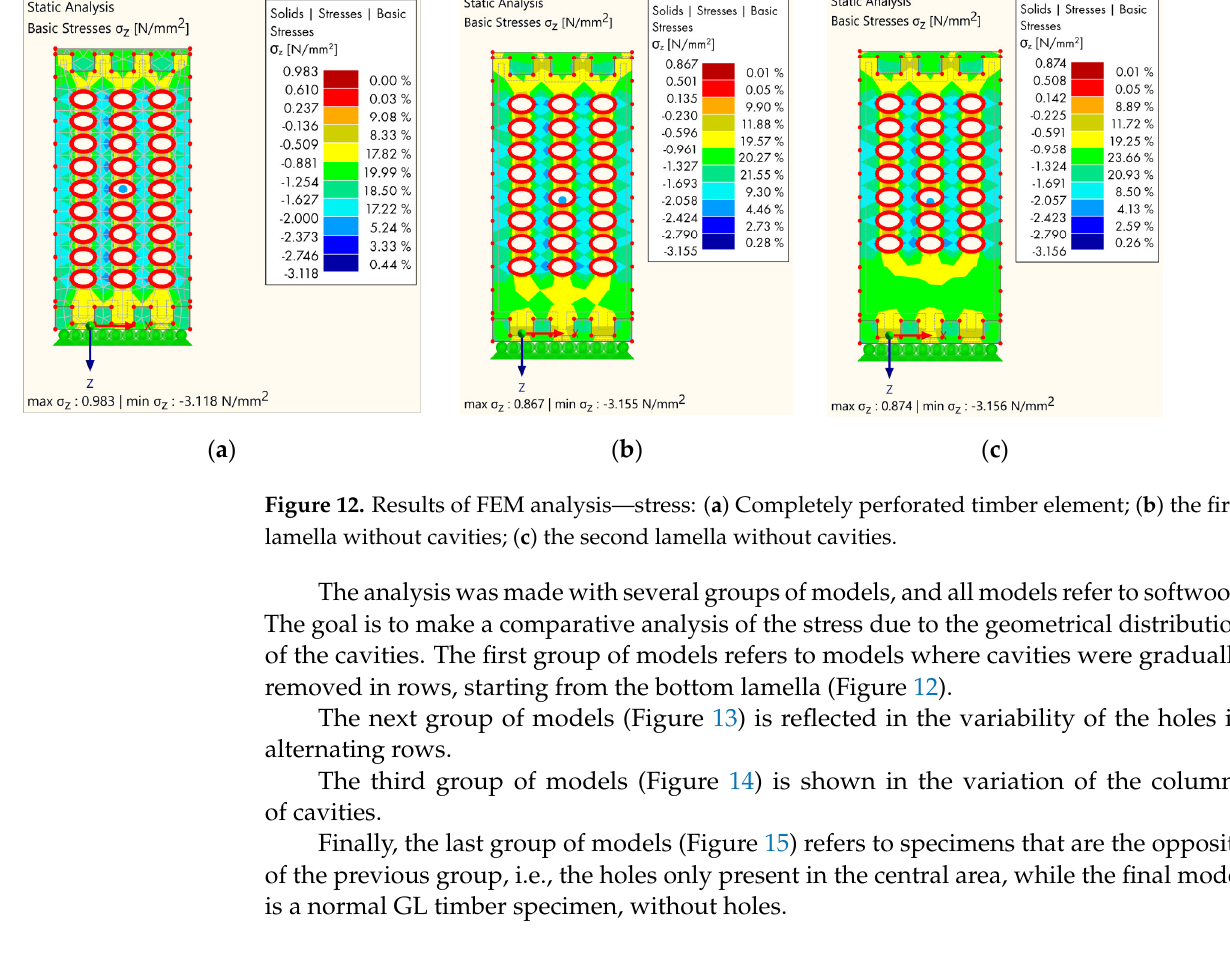
( c ) Figure 13. Results of FEM analysis—stress: ( a ) Each subsequent lamella without cavities; ( b ) alter- nating arrangement of holes, type 1; ( c ) alternating arrangement of holes, type 2. The third group of models (Figure 14) is shown in the variation of the columns of cavities.